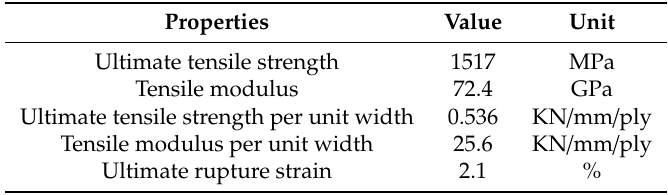
Table 3. Fabric GFRP properties.